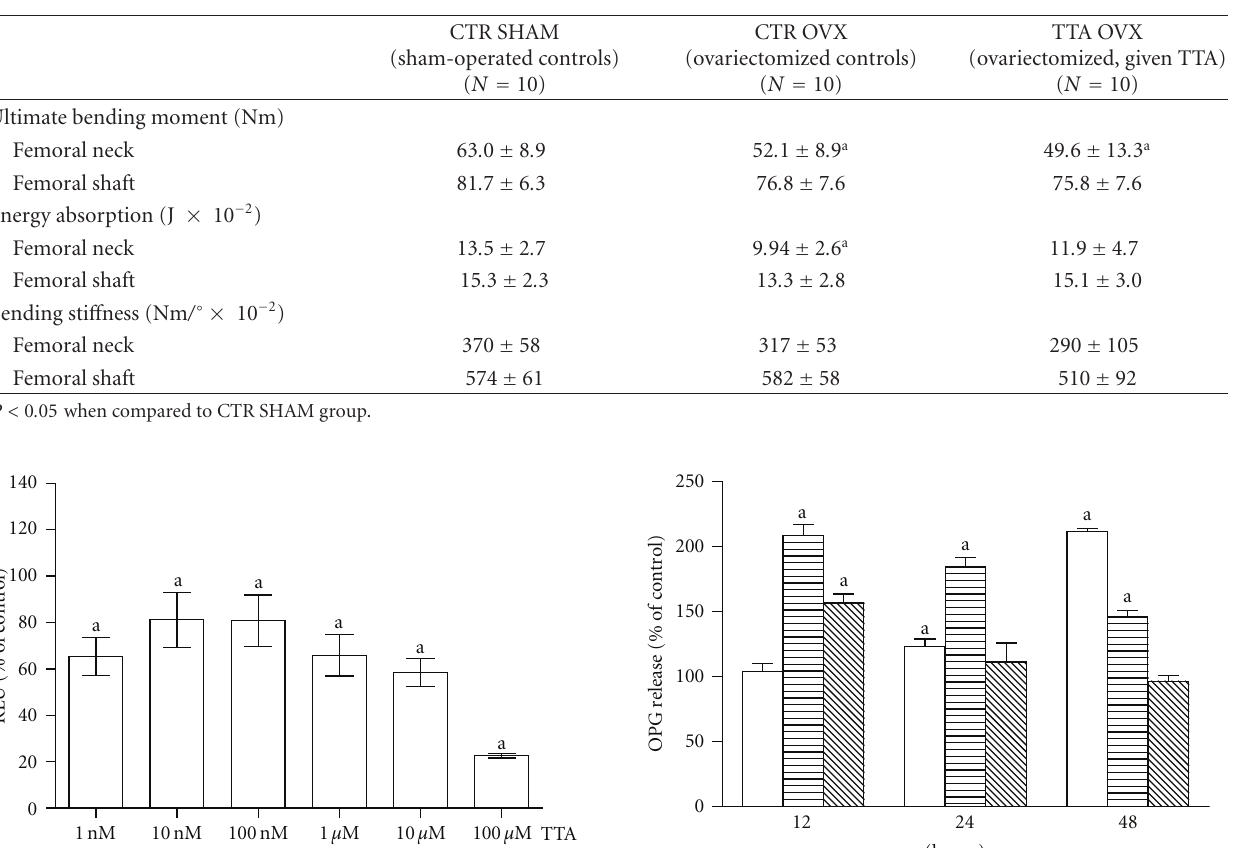
Table 7: Biomechanical properties of the femoral neck and shaft in mean values ± SD in sham controls, ovariectomized controls, and ovariectomized rats fed TTA for four months (Study II).